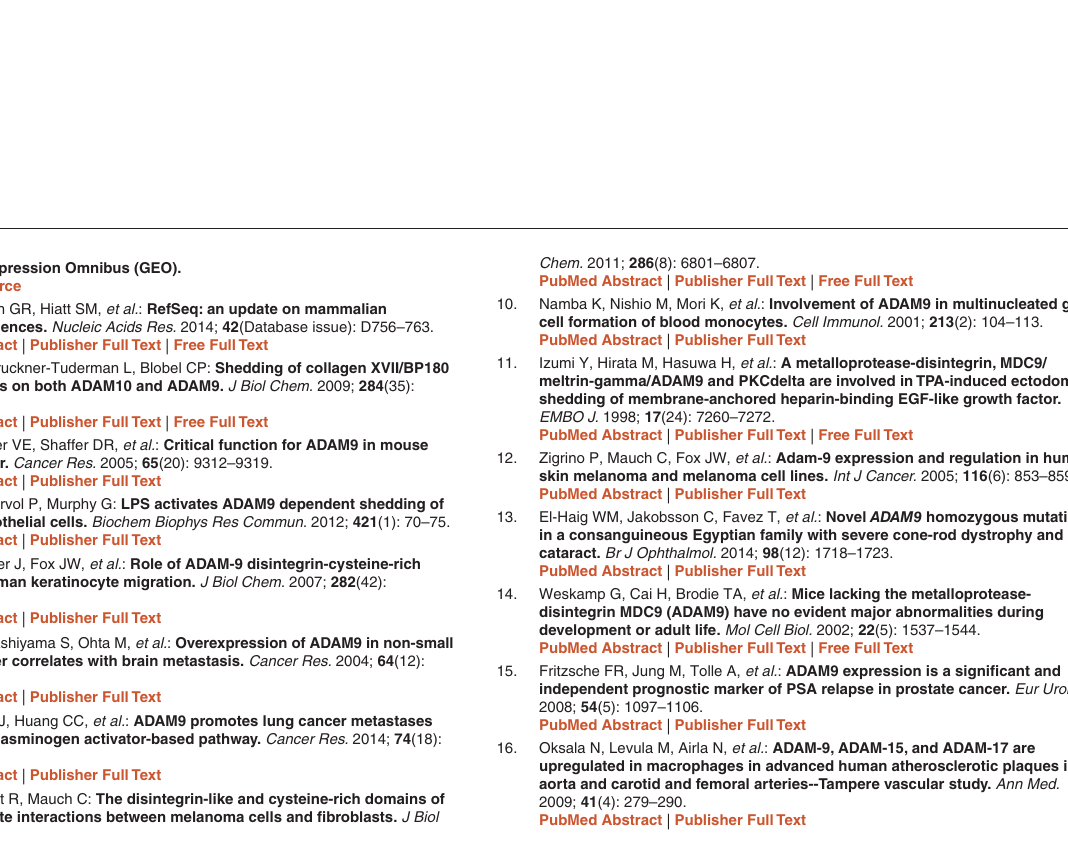
Supplementary Figure 6. The abundance of ADAM9 increases in different models of tissue injury. mRNA expression levels for ADAM9 was measured by microarrays in a murine inflammatory lung injury and mechanical ventilation model (GSE2411), an in vitro human epidermal injury model (GSE30355) and mouse thermal injury model (GSE460). These raw data were exported from GEO and were plotted by GraphPad Prism. ❶ GSE460 Thermal injury was induced in mice, and skin excised at 0 hours, 2 hours, 3 days and 14 days post-injury. https://www.ncbi.nlm.nih.gov/geo/tools/profileGraph.cgi?ID=GDS353:96738_at ❷ GSE30355 Keratinocyte response to injury was evaluated in (1) epidermal samples isolated by laser capture microscopy and (2) cultured KCs https://www.ncbi.nlm.nih.gov/geo/tools/profileGraph.cgi?ID=GDS4608:1570042_a_at ❸ GSE2411 Twenty four C57/B6 male mice were randomized to four groups: 1) Control, 2) mechanical ventilation (MV), 3) LPS, and 4) MV+LPS. Expression profiling of whole lungs revealed a significant augmentation of ADAM9 transcript levels in the combined MV+LPS group relative to the other 3 conditions.